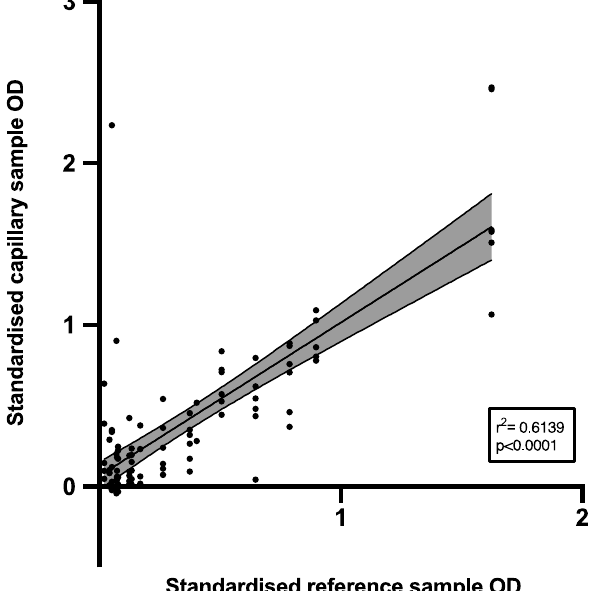
Figure 1. Linear relationship between standardised OD values of matched venous plasma collected in lithium heparin treated tubes and all capillary samples positive for SARS-CoV-2